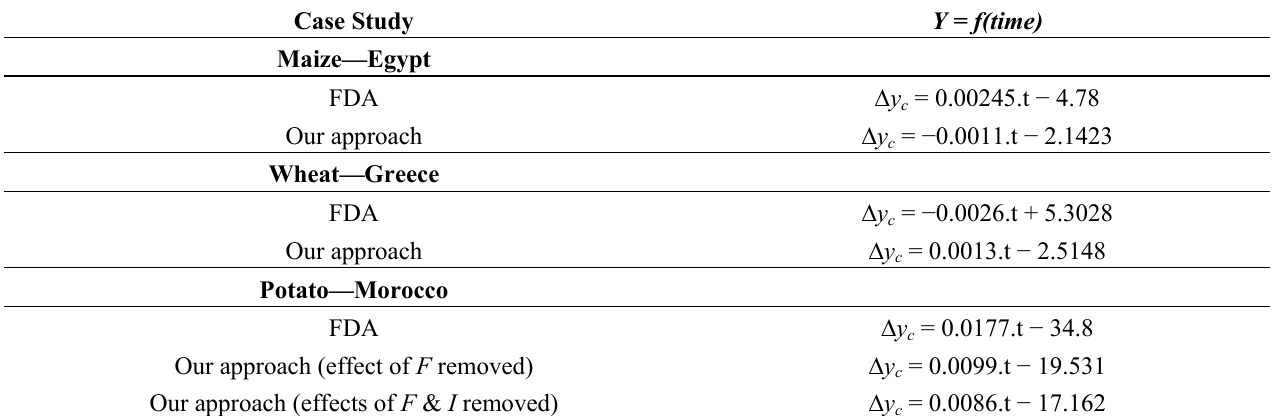
Table 3. Results of crop yield trend analyses. Year to year variation in the climate-induced (t.ha 1 ), is expressed as a function of time, t (in years). FDA refers to the crop yield, ∆ y c first-difference approach, while F and I refer to fertilizers and irrigation applications ( i.e ., when their effects on the temporal crop yield evolution were